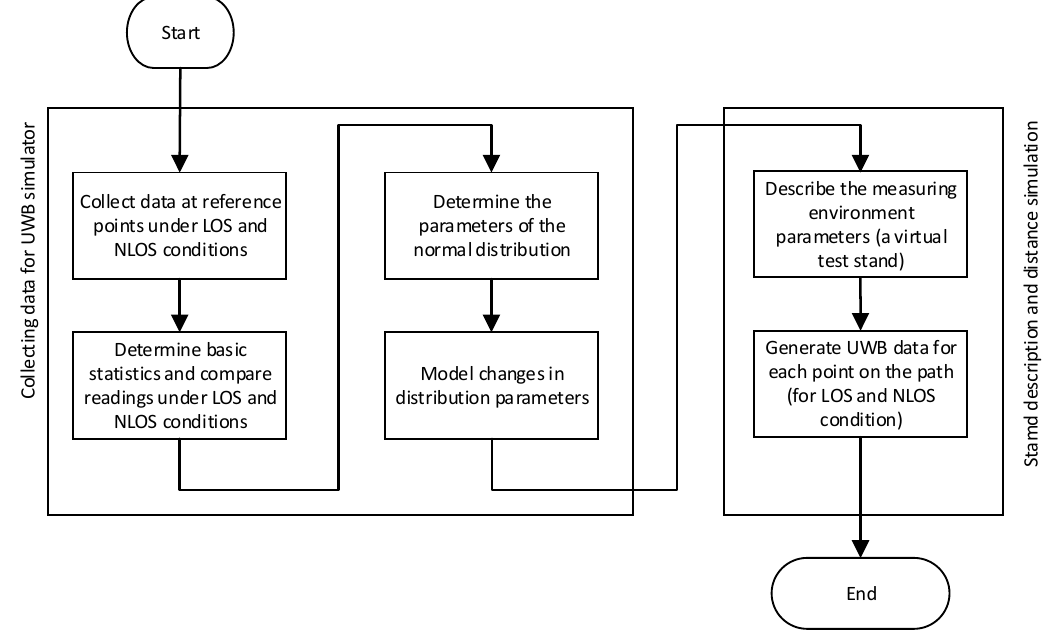
Figure 1. Main block diagram of the data analysis.